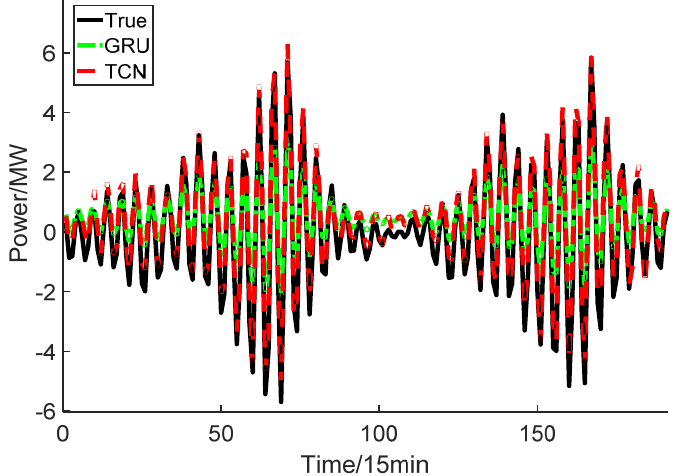
Figure 10. The forecasting results of GRU and TCN with high-frequency component.